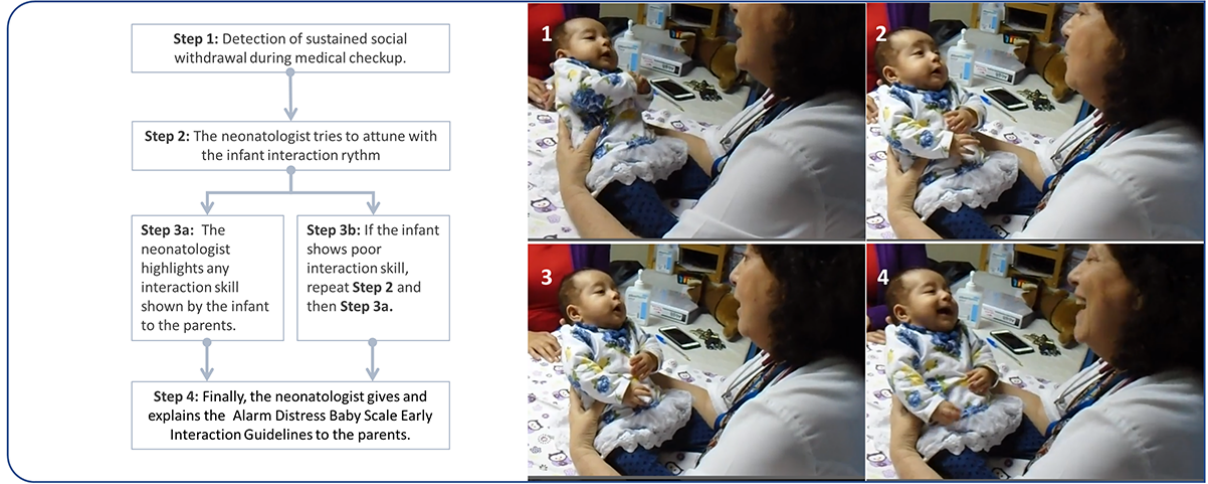
Figure 2. Summary of the steps of the interactive guidance intervention during medical